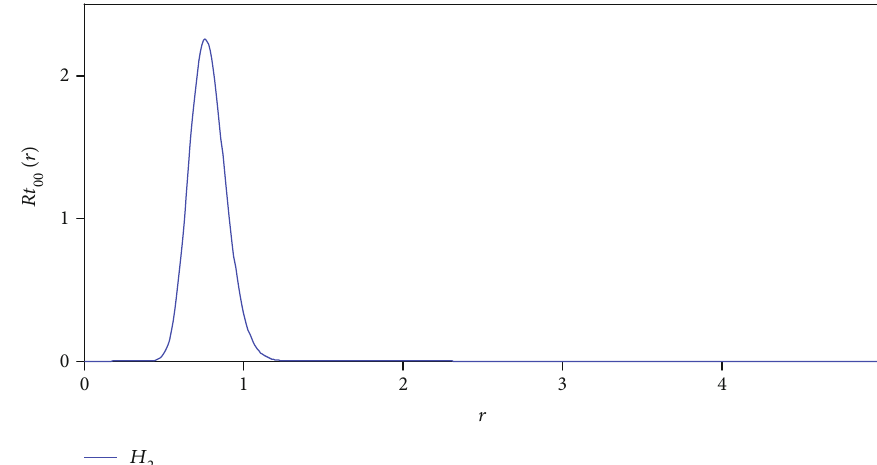
Figure 3: Wave function ð eV Þ in terms of r ð A 0 Þ of Deng-Fan potential for H